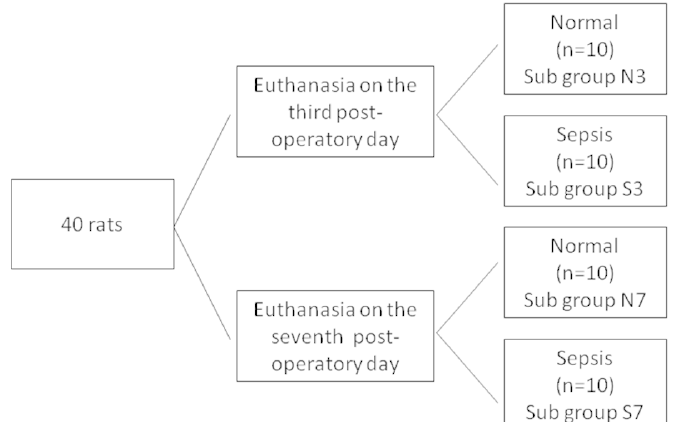
FIGURE 1 - Allocation of subjects